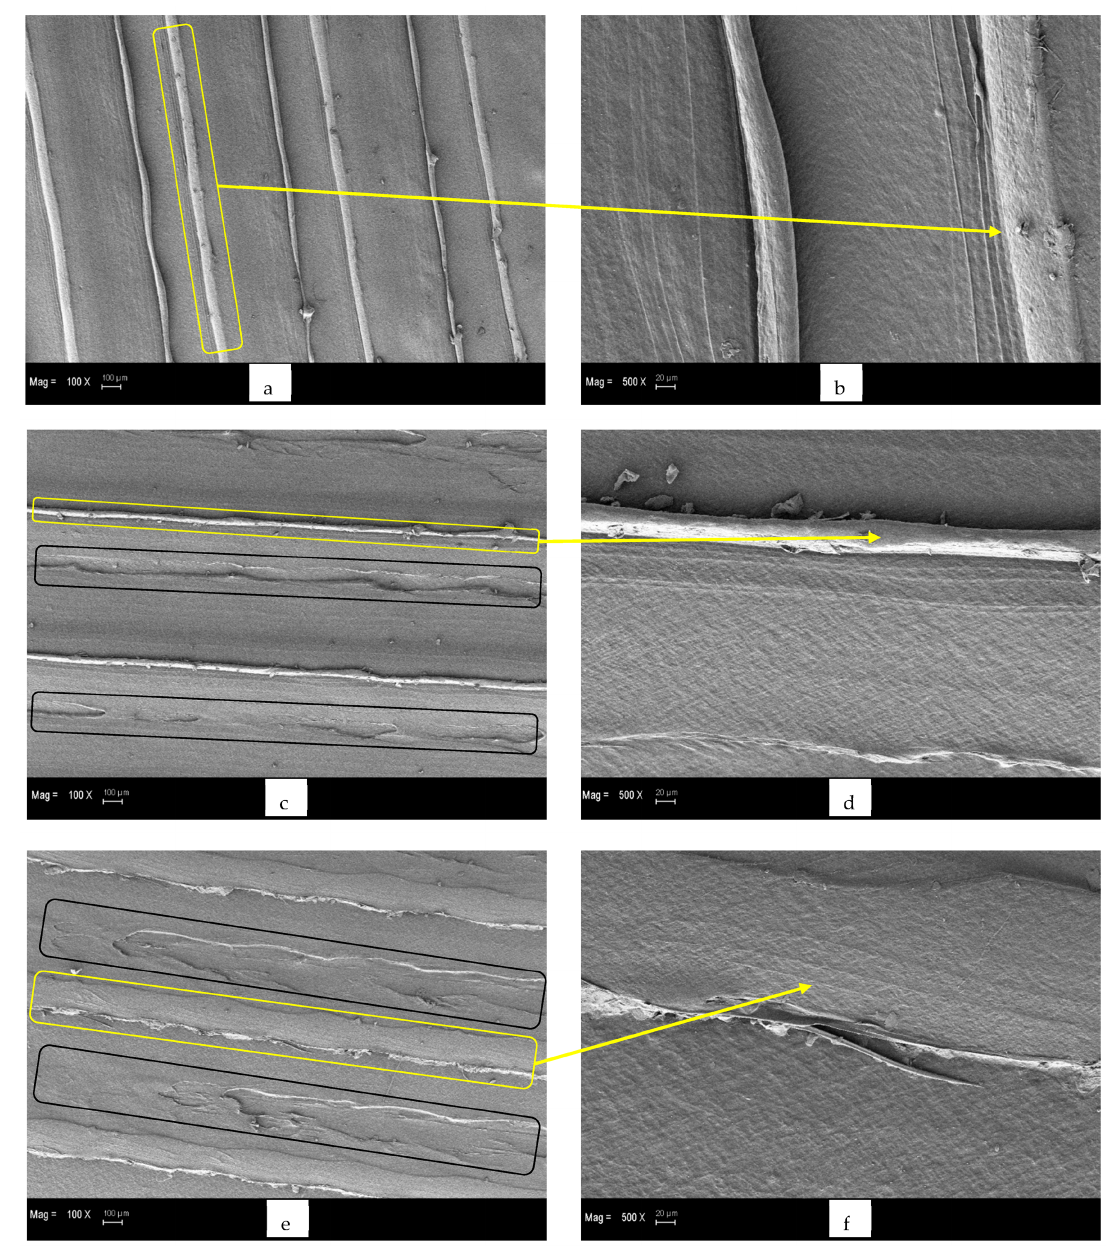
Figure 8. SEM micrographs of ( a , b ) non-cured, ( c , d ) 30 min post-UV-cured and ( e , f ) 60 min post-UV-cured PLA specimens produced at 190 °C .